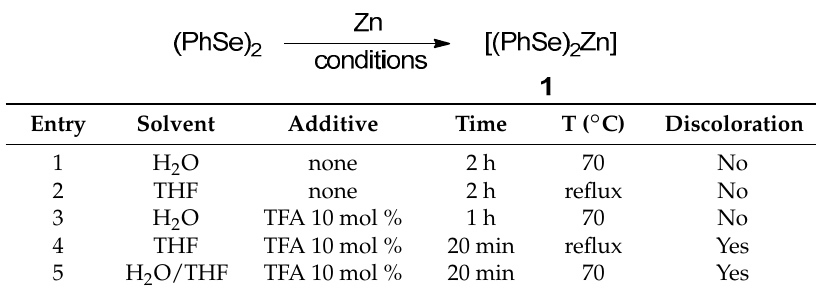
Table 1. Synthesis of compound 1 .